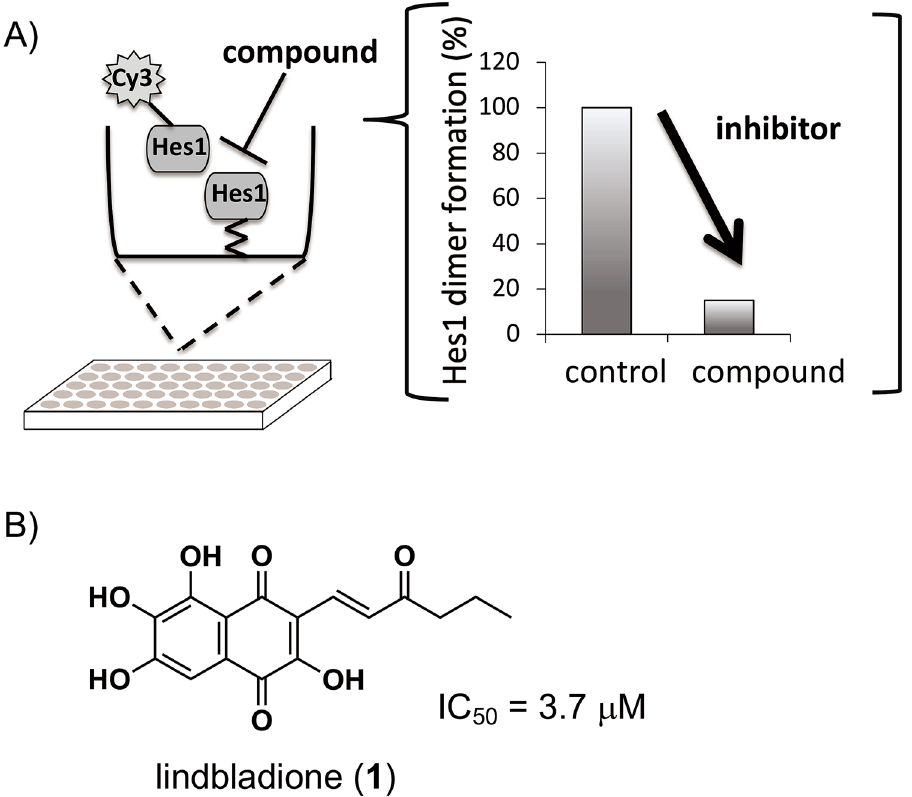
Figure 2. Screening of Hes1 dimerization inhibitors. ( A ) Hes1–Hes1 interaction fluorescent plate assay; ( B ) the first Hes1 dimerization inhibitor, lindbladione ( 1 ) and IC 50 value of Hes1 dimer inhibition of natural product 1 (ref